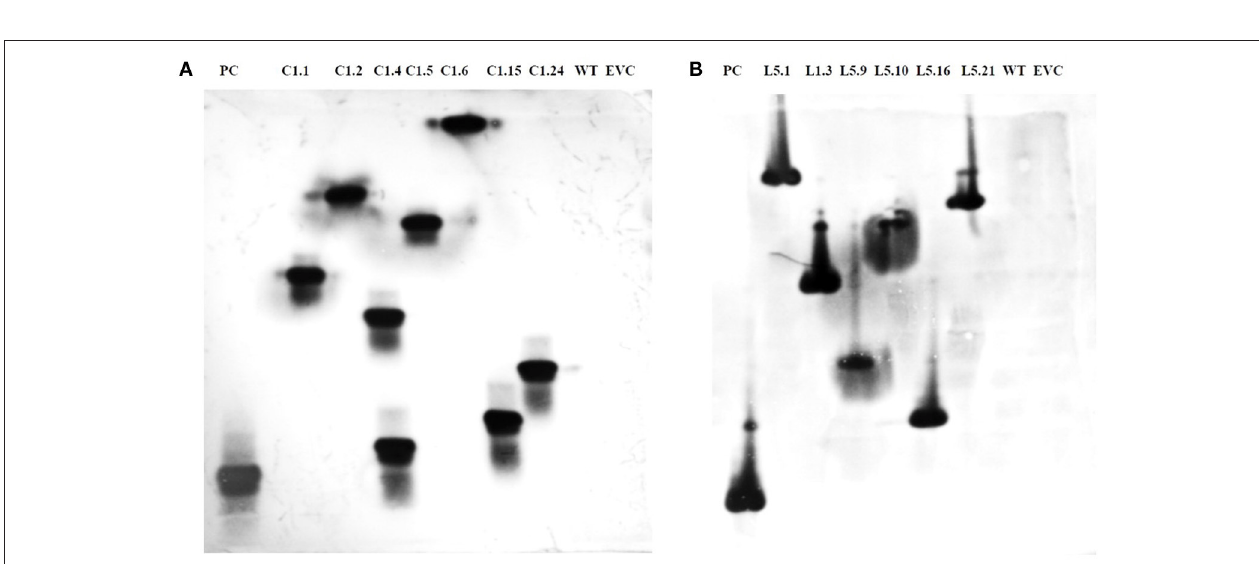
FIGURE 5 | Southern blot depicting T-DNA integration in T 1 plants harboring dsRNA of (A) Mi-col-1 and (B) Lemmi-5. Mi-col-1 events are C1.1, C1.2, C1.4, C1.5, C1.6, C1.15 and C1.24; Lemmi-5 events are L1.1, L1.3, L1.9, L1.10, L1.16, and L1.21; PC denotes positive control probe of respective genes; WT denotes untransformed wild type tomato “Pusa Ruby,” EVC denotes empty vector controls for the respective gene constructs.